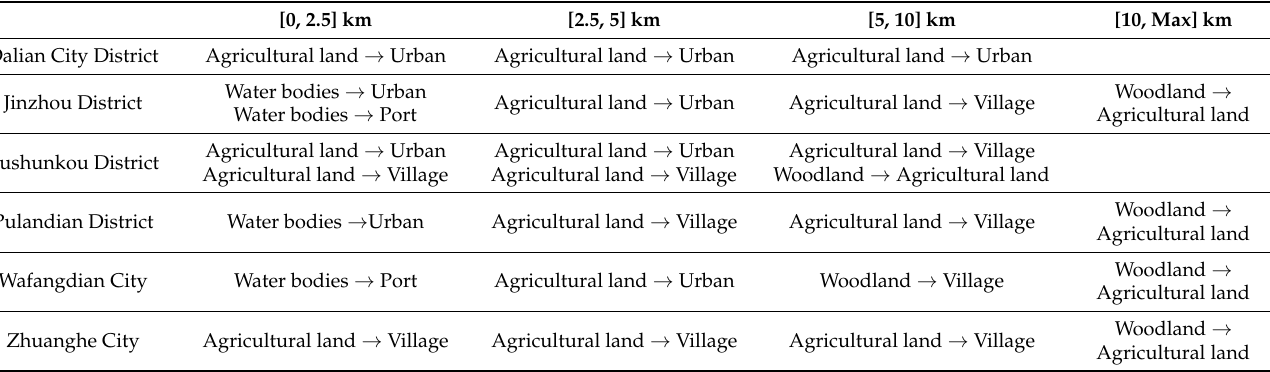
Table 9. Maximum direction of net land use transfer by administrative districts in